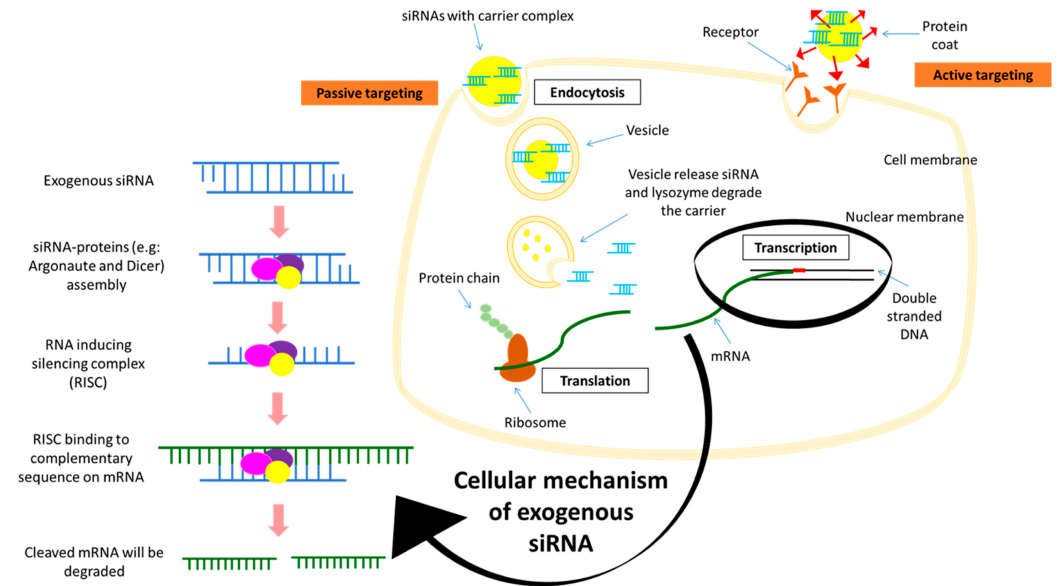
Figure 2. Schematic diagram of the mechanism of small interfering RNA (siRNA) in targeting mRNA for gene silencing (left) and exogenous siRNA duplex delivery into the cytoplasmic region via passive and active targeted delivery